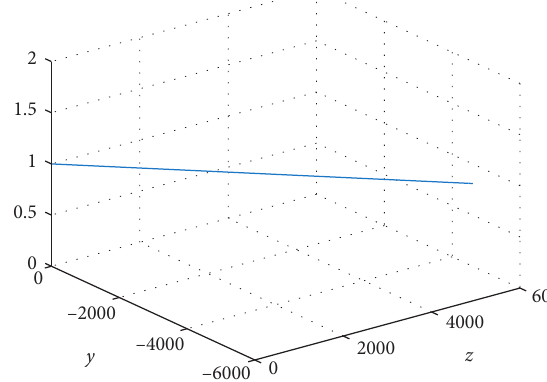
Figure 1: Convergence of x